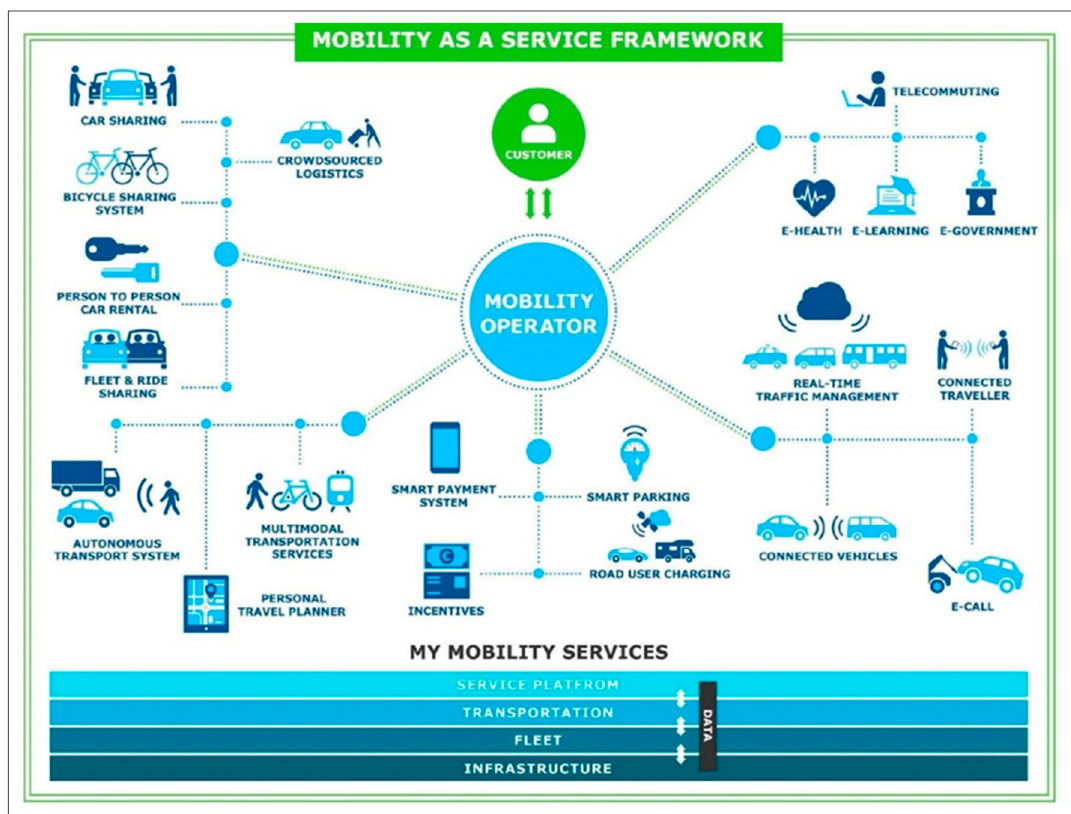
Figure 1. The Mobility as a Service framework. Reproduced from Kivimäki et al. [11].